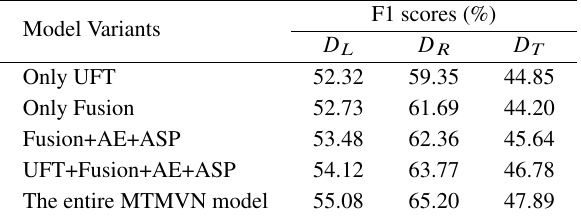
Table 5 Comparison results in the F1 scores (%) of different model variants.